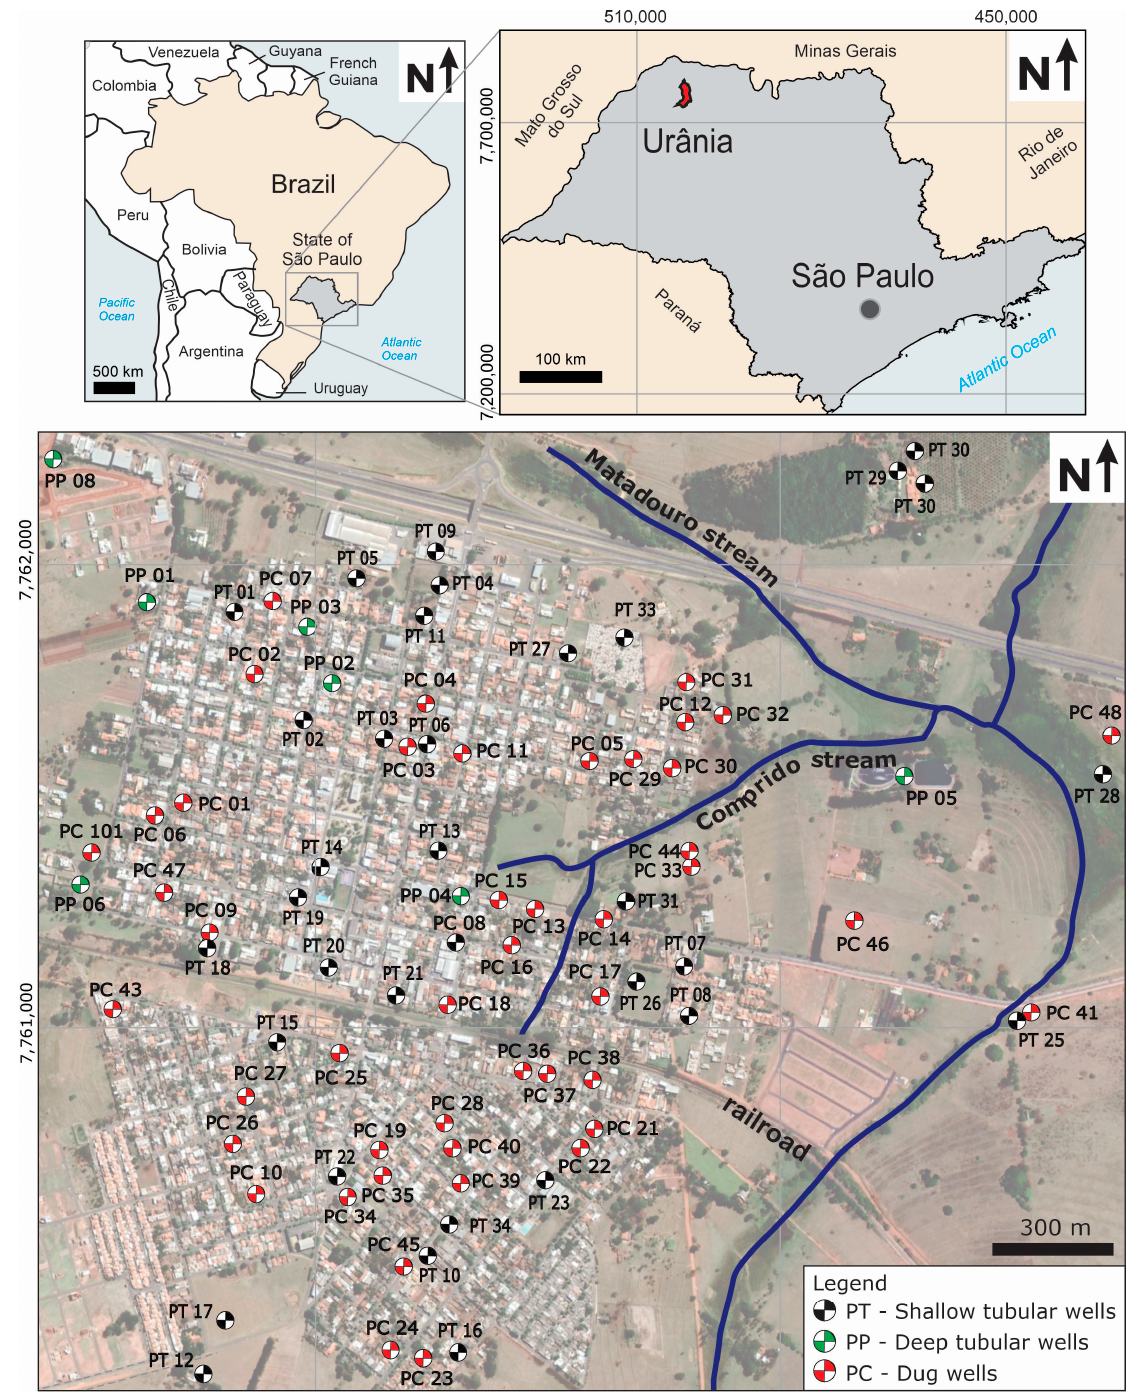
Figure 1. The city of Urânia (São Paulo, Brazil) and its dug wells (<20 m), shallow tubular wells (20 m–60 m) and deep tubular wells (>60 m).